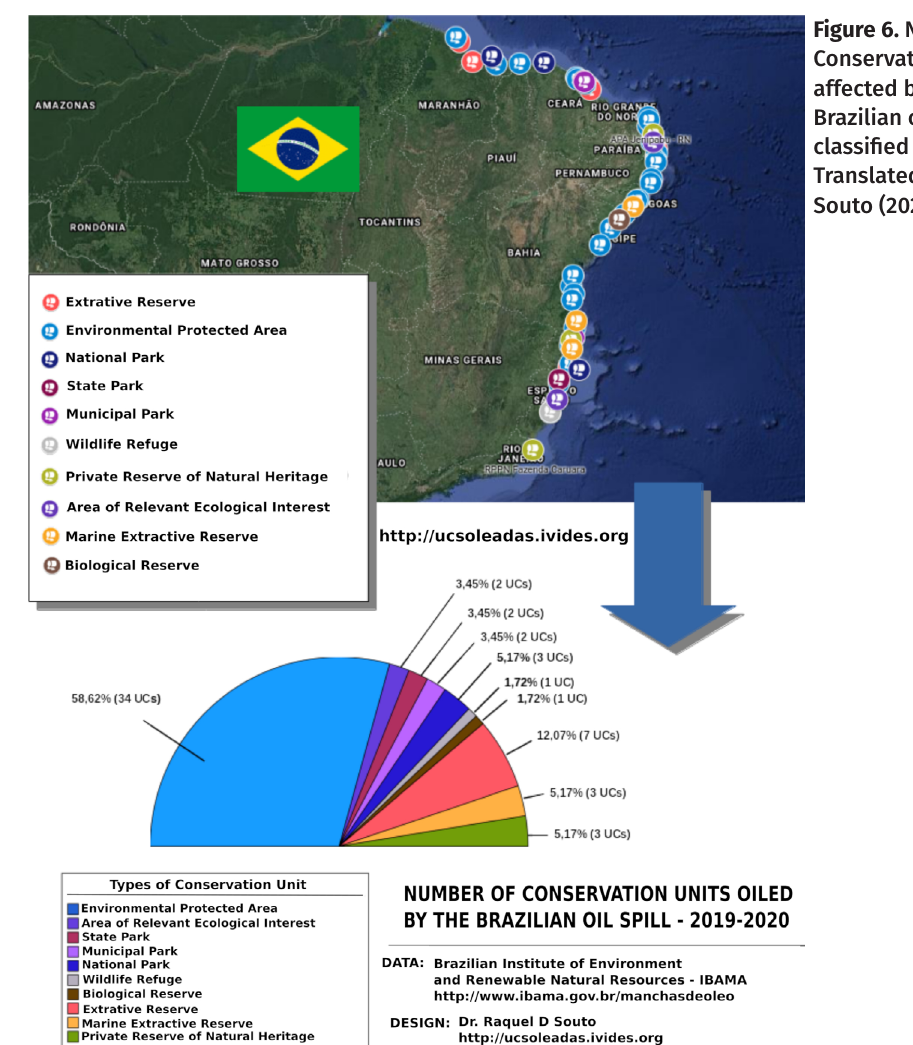
Figure 6. Nature Conservation Units affected by the Brazilian oil spill, classified by its type. Translated from Souto (2020a, p.